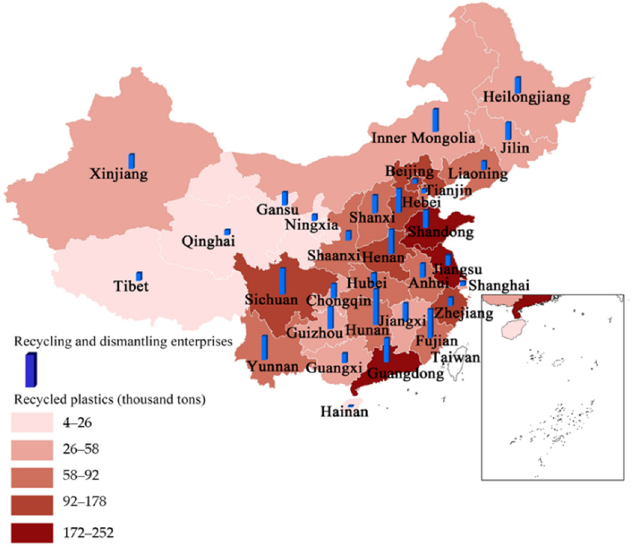
Figure 6. The spatial distribution of EoL passenger vehicle plastic recycling potential in China’s provinces in 2030 (under the BAU scenario).